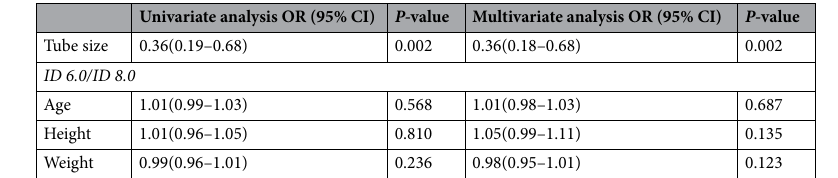
Table 3. Univariate and multivariate analysis of inadequate intracuff